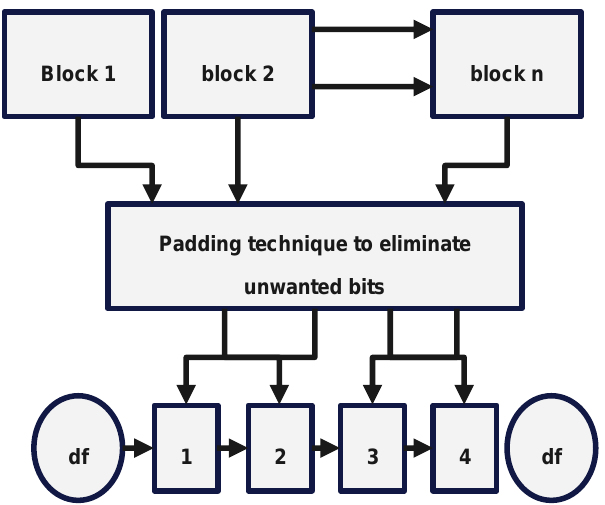
Figure 4. The Merkle – Damgård construction.